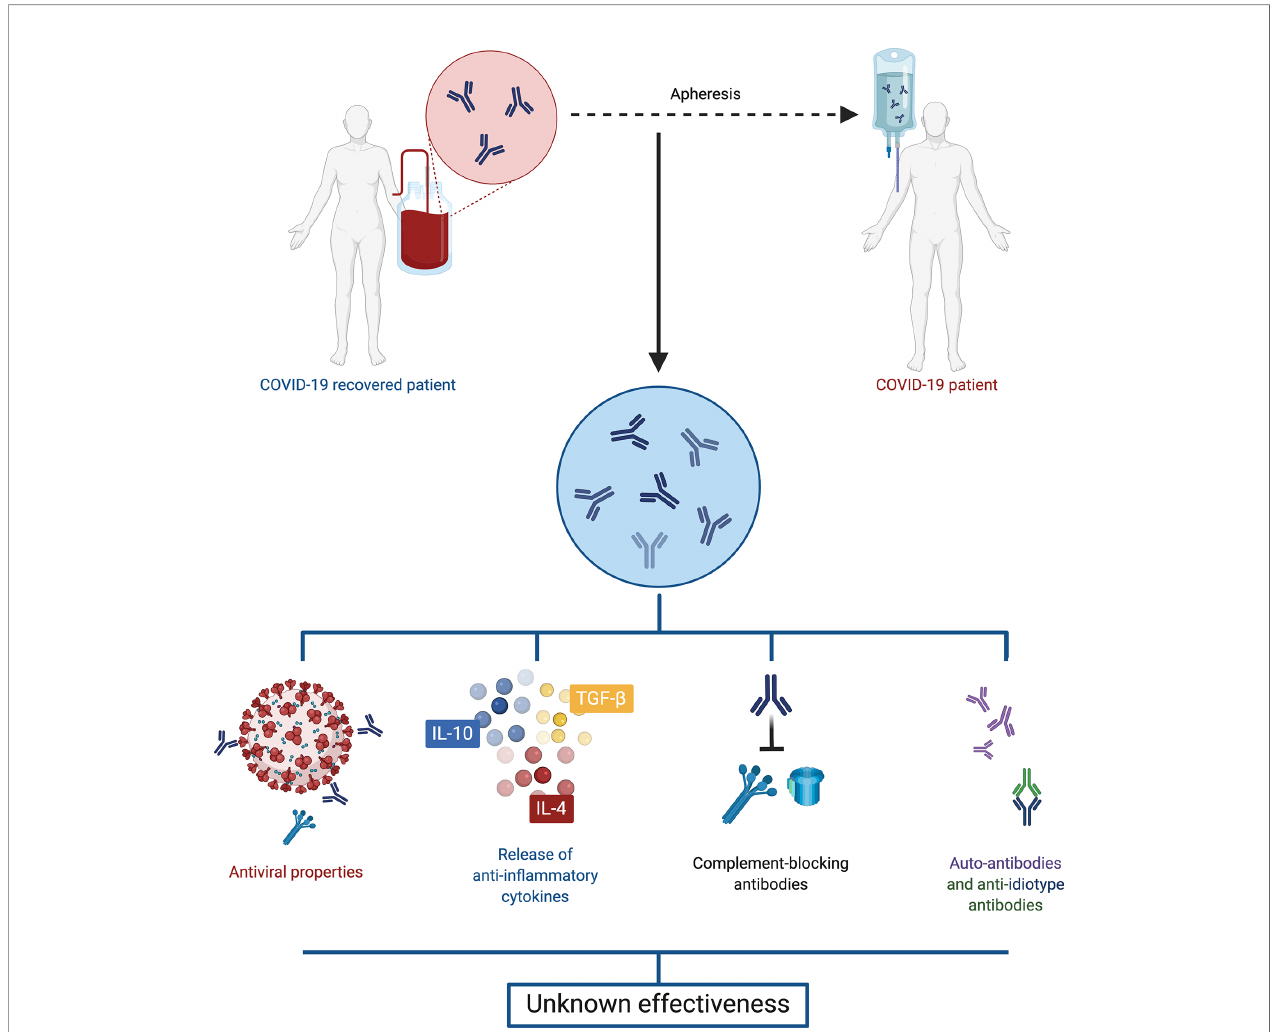
FIGURE 3 | Convalescent plasma. Plasma retrieved from convalescent COVID-19 patients displays both antiviral and immunomodulatory properties, including anti- in fl ammatory cytokines, complement blocking antibodies, auto-antibodies and anti-idiotype antibodies. However, evidence is so far contradictory, and the effectiveness of this treatment is